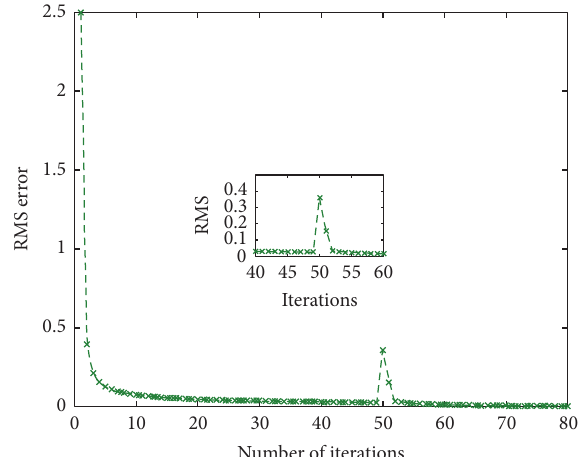
Figure 5: RMS error curve without actuator failure.